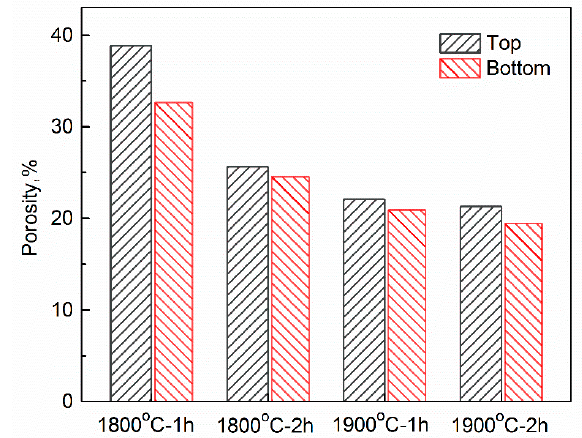
Figure 5. Porosities of the top and bottom parts of porous α -SiAlON samples fired at different conditions.